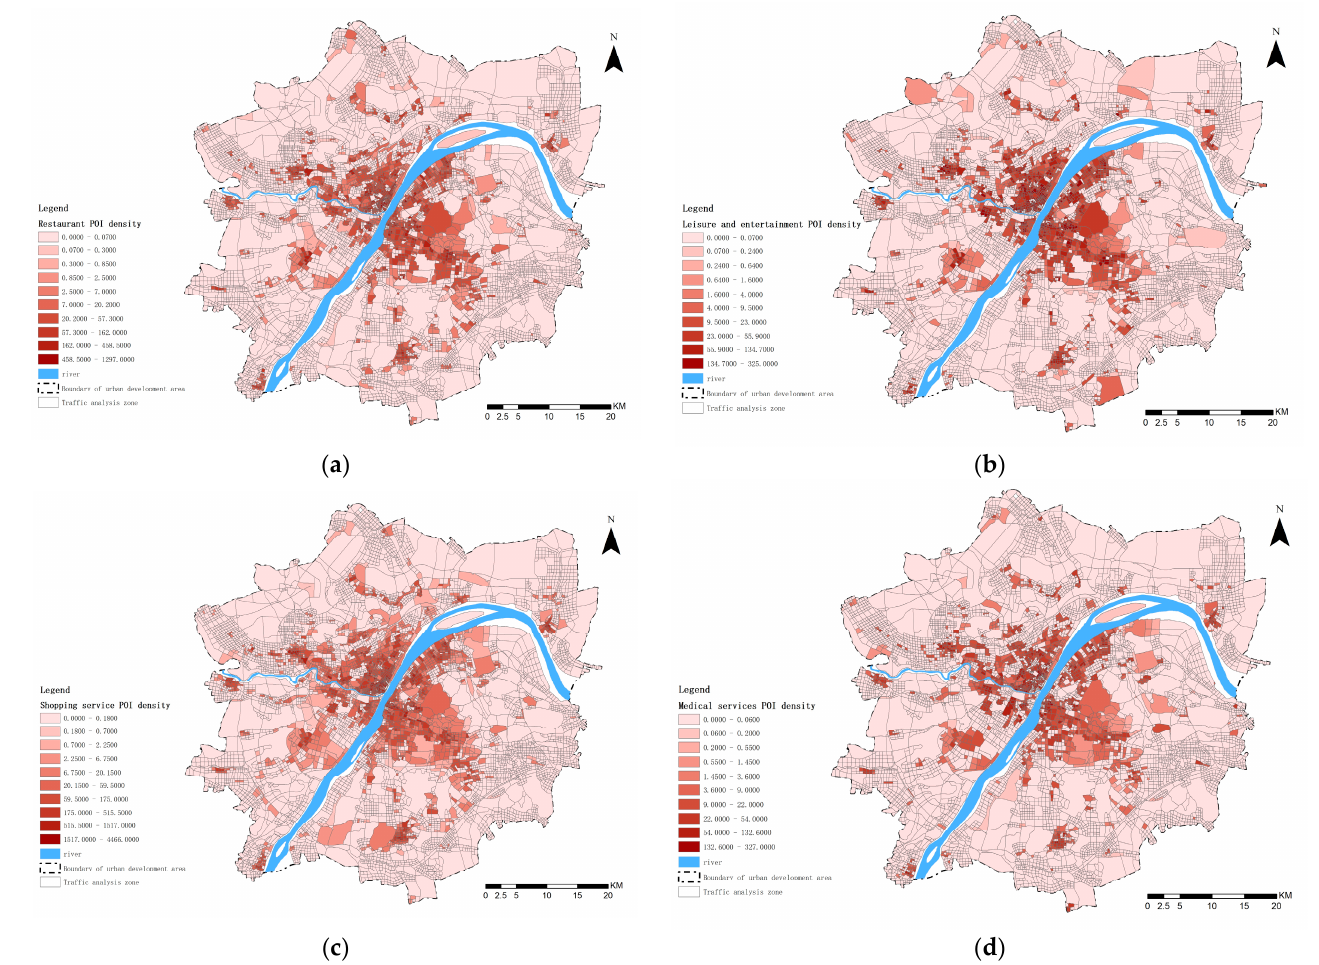
Figure 12. Daily life service facilities: ( a ) Restaurant POI density; ( b ) Leisure and entertainment POI density; ( c ) Shopping service POI density; ( d ) Medical services POI density.